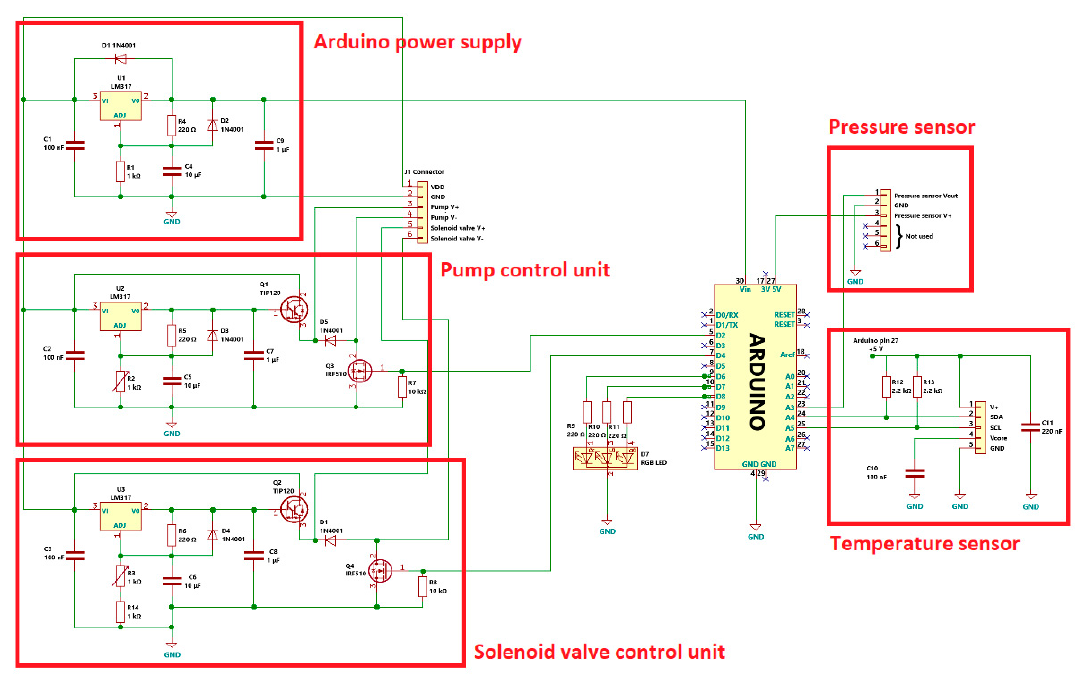
Figure 1. Electronic diagram of the system.